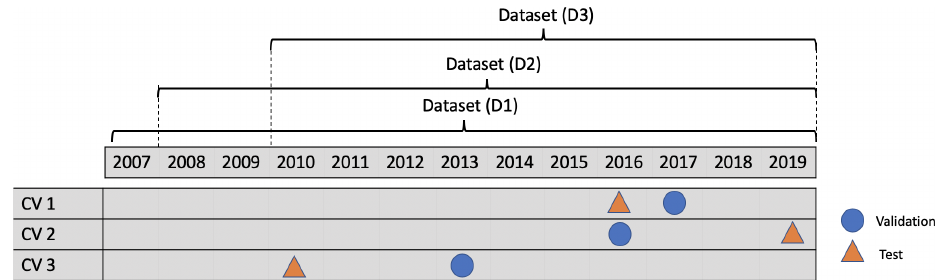
Figure 2. The three cross-validation datasets (CV 1, CV 2, and CV 3) consist of different training, validation, and testing samples from the 13 years ERA5 reanalysis data between 2007 and 2019. Each row represents one data partition. The three datasets (D1, D2, and D3) consist of samples from 2007 to 2019, from 2008 to 2019, and from 2010 to 2019,